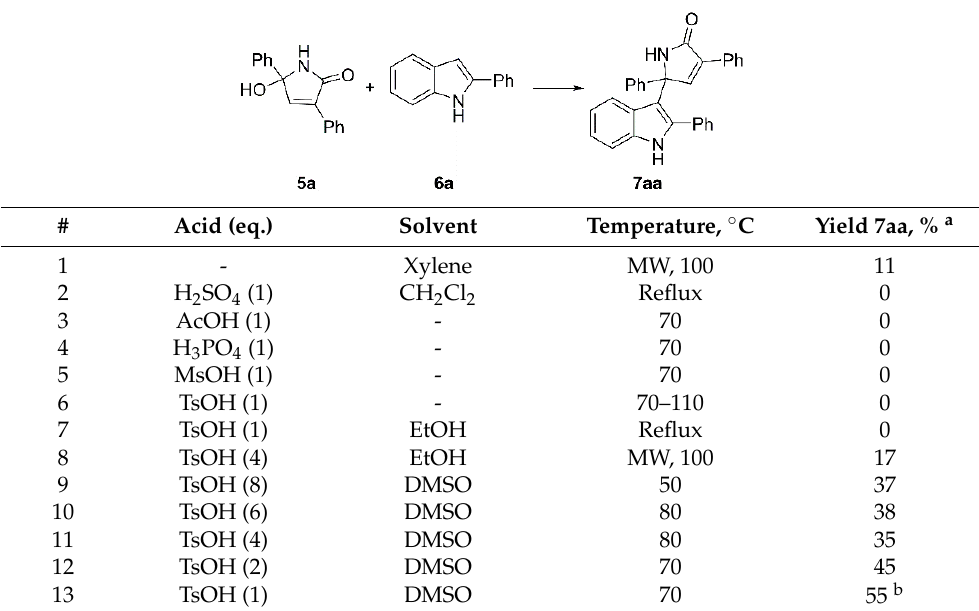
Table 1. Screening of reaction conditions for the reaction of 2-phenylindole 6a with 5-hydroxy-3,5-